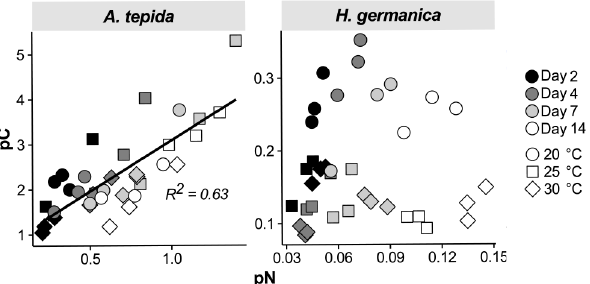
Figure 7. Carbon and nitrogen coupling. Phytodetrital-derived ni- trogen (pN) vs. carbon (pC) of A. tepida and H. germanica at 20 ◦ C (circles), 25 ◦ C (squares) and 30 ◦ C with linear regression for A. tepida